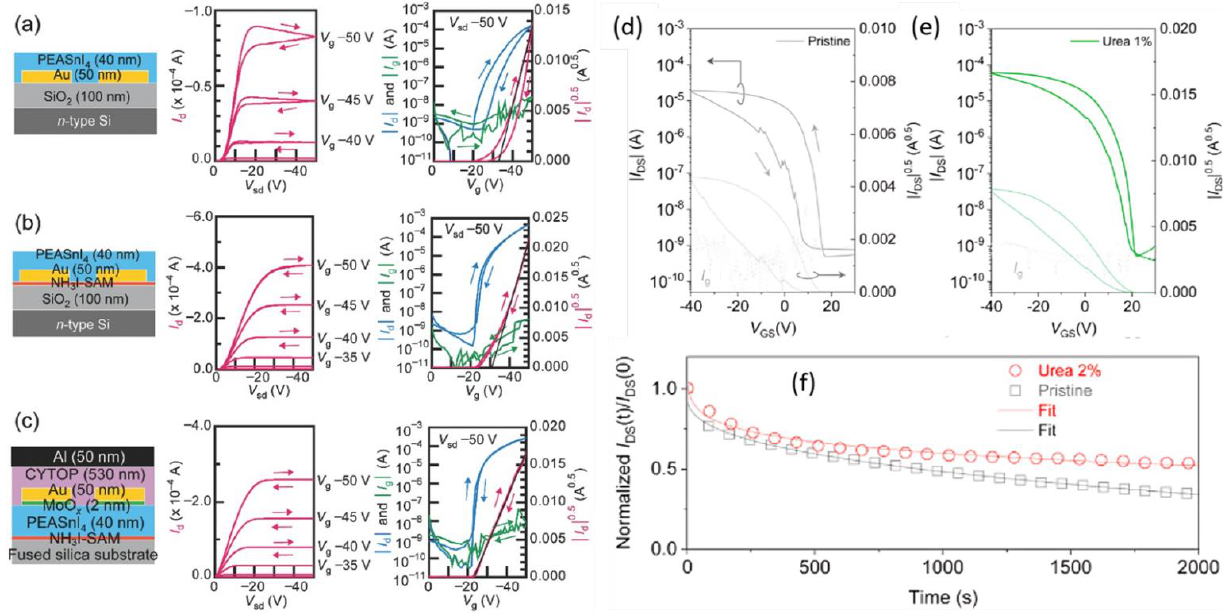
Figure 12. ( a ) Representative output and transfer characteristics of BC/BG transistors ( a ) without Self Assembled Monolayer (SAM), ( b ) with NH 3 I-SAM and ( c ) TC/TG transistors with NH3I-SAM when measured with forward and reverse scans at a scan rate of 5 Vs − 1 . Gate currents (Ig), which are correlated with leakage currents occurring through gate dielectrics, are also shown in each Figure. Ig is not so large compared with Id for all of the transistors. Reproduced with permission from [90]. Copyright 2016 WILEY-VCH Verlag GmbH & Co. KGaA, Weinheim. Transfer characteristics of ( d ) pristine and ( e ) 2% urea-added (PEA) 2 SnI 4 perovskite-based FETs and ( f ) their current stability over time. Reproduced with permission from [175]. Copyright 2021 Elsevier